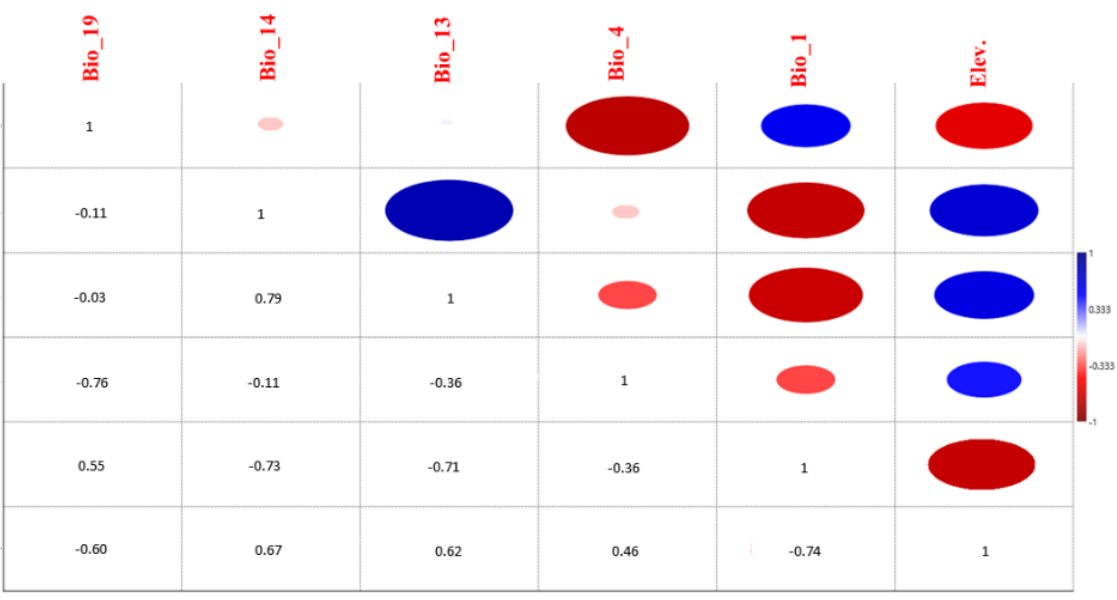
Figure 2. Pearson correlation analysis of significative environment variables for Salvia ceratophylloides Ard. ( − 0.8 ≤ r ≤ +0.8). Created with Past 4.1.4 © (Hammer, Oslo, Norway).